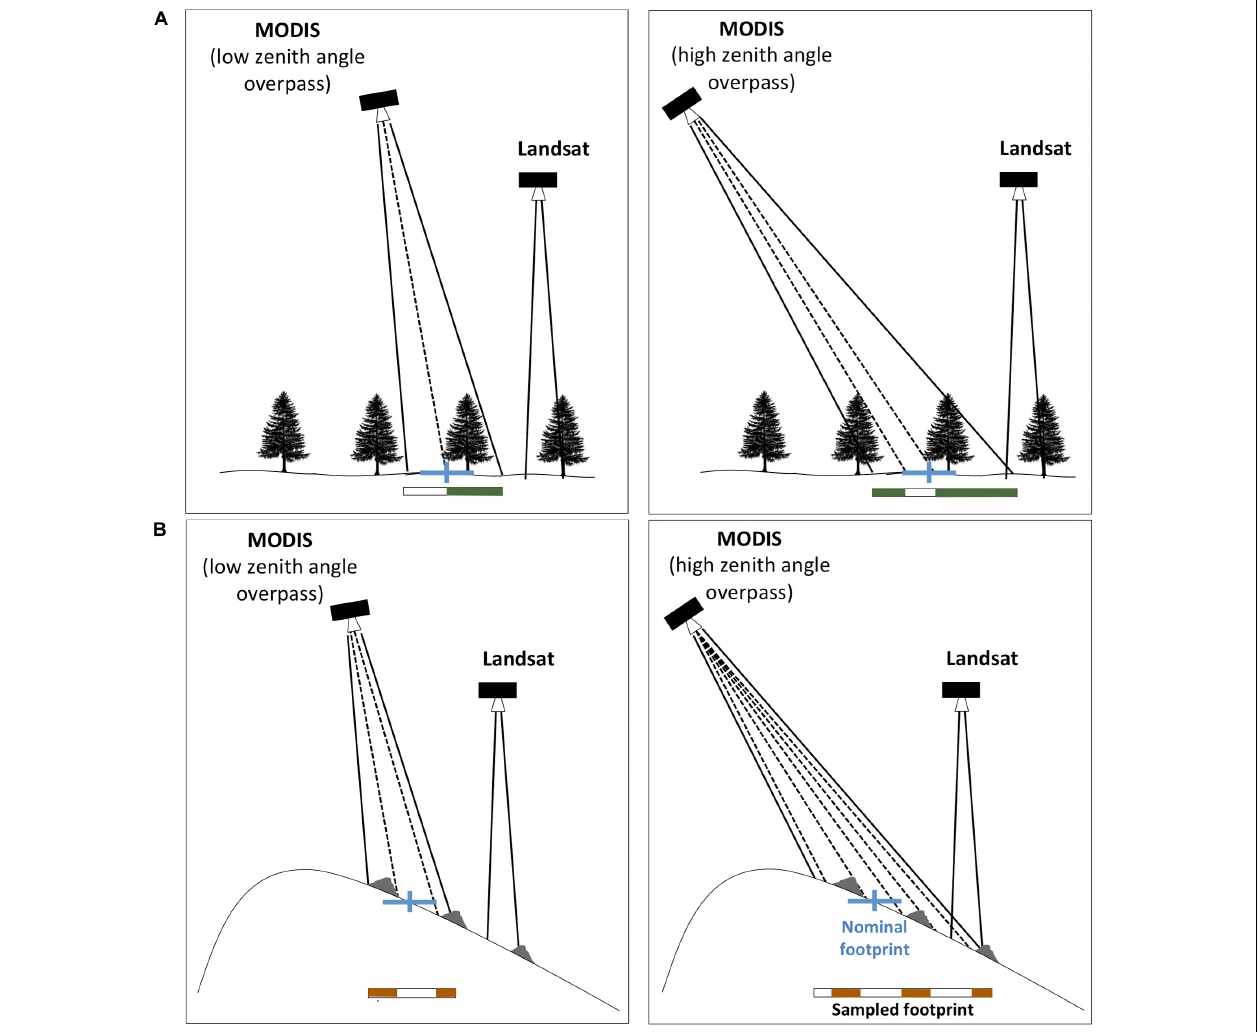
FIGURE 4 | Schematic illustrating the time-varying viewing geometry effects of MODIS on fractional snow covered area (fSCA) retrieval: (A) illustrative impacts of forest cover on sampled footprint at two viewing angles (low zenith angle on left and high zenith angle on right). The blue lines represent a MODIS grid point center (vertical tick) and nominal resolution (horizontal line; ∼ 463 m), at which the retrieval is provided. The actual sampled footprint is represented by the white rectangle that is filled with white and green representing snow and forest respectively that is actually seen by the sensor within its sampled footprint. In the case shown on the right, for the same snow on the ground, the MODIS sampled footprint will see more forest and therefore less snow. (B) Illustrative impacts of topography and rock outcrops (shown in gray). The actual sampled footprint is represented by the white rectangle that is filled with white and brown (representing snow and rock respectively) within the footprint. The “stretching” of the sampled footprint in the scanning direction will distort the retrieved fSCA that is mapped into the nominal footprint due simply to the viewing angle. In contrast, the Landsat viewing angle does not